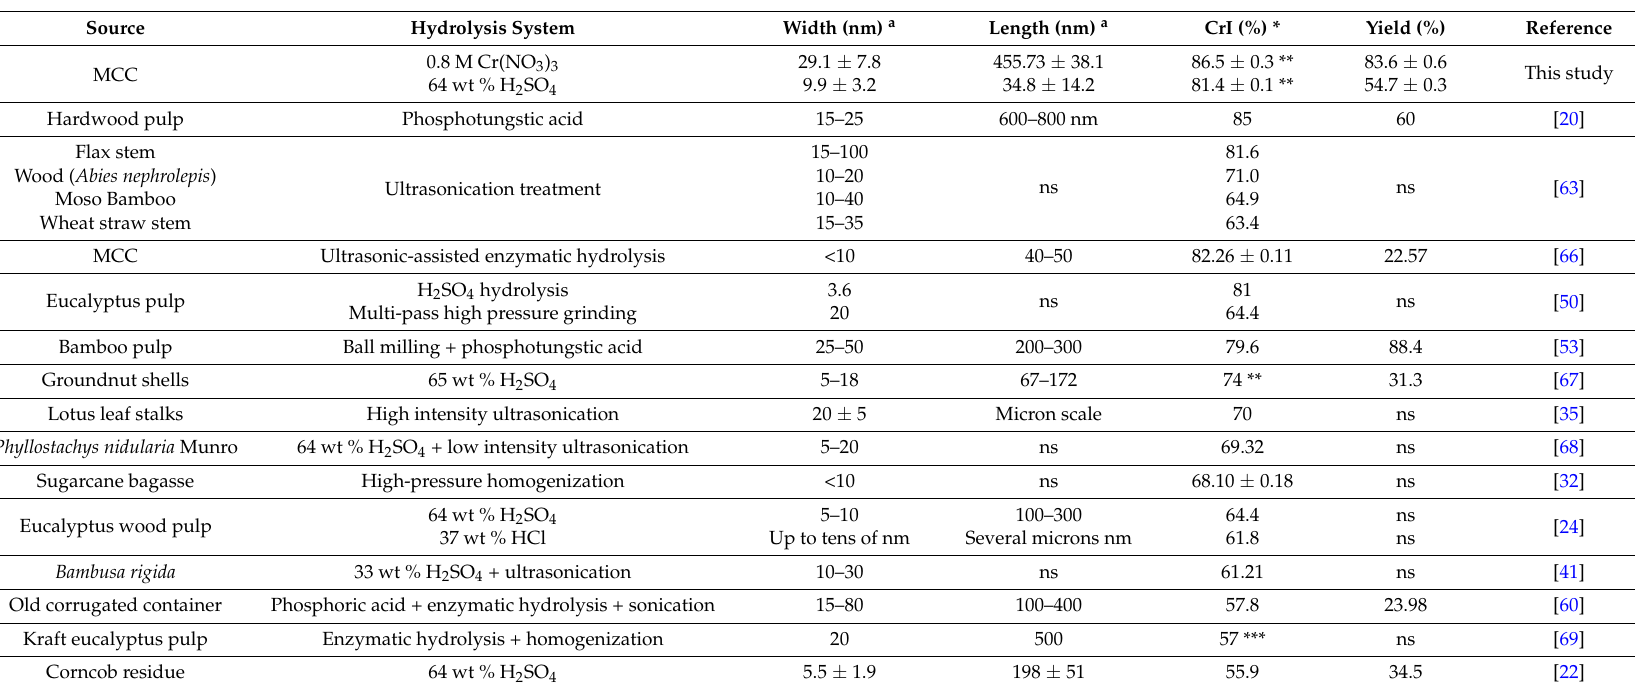
Table 3. Summary of the most important characteristics (i.e., hydrolysis conditions, crystallinity index, and fiber morphology) of produced nanocellulose derived from different